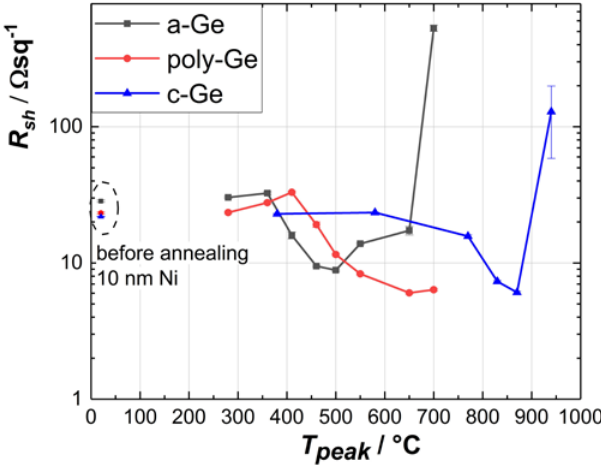
Figure 2. Sheet resistance of flash lamp annealing (FLA)-treated Ni / Ge structures with 10 nm Ni. Table 1. Selected results with lowest sheet resistances with corresponding peak temperatures. The specific resistivities ( ρ ) were calculated by using atomic densities and unit cell volumes from [28].